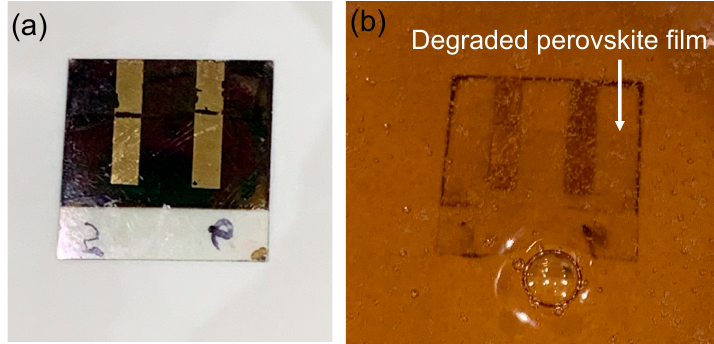
Figure 2. Photographs of the device ( a ) before and ( b ) after contact with vinyl-ester resin.